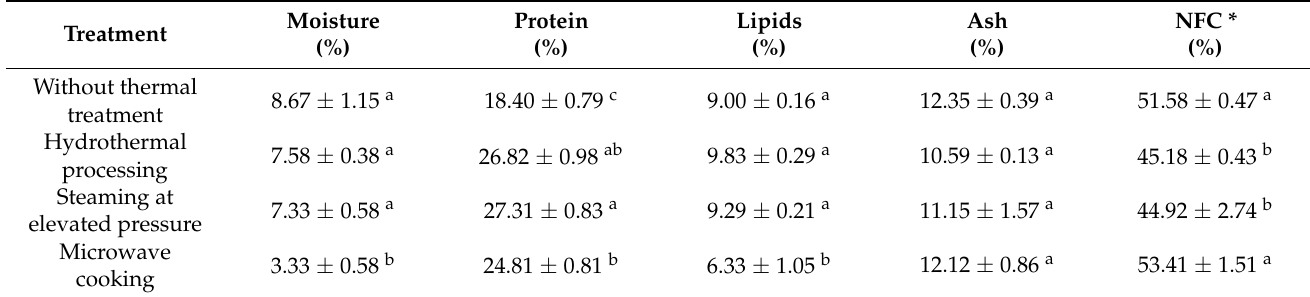
Table 1. Proximal analysis of Pacaya inflorescences with different thermal